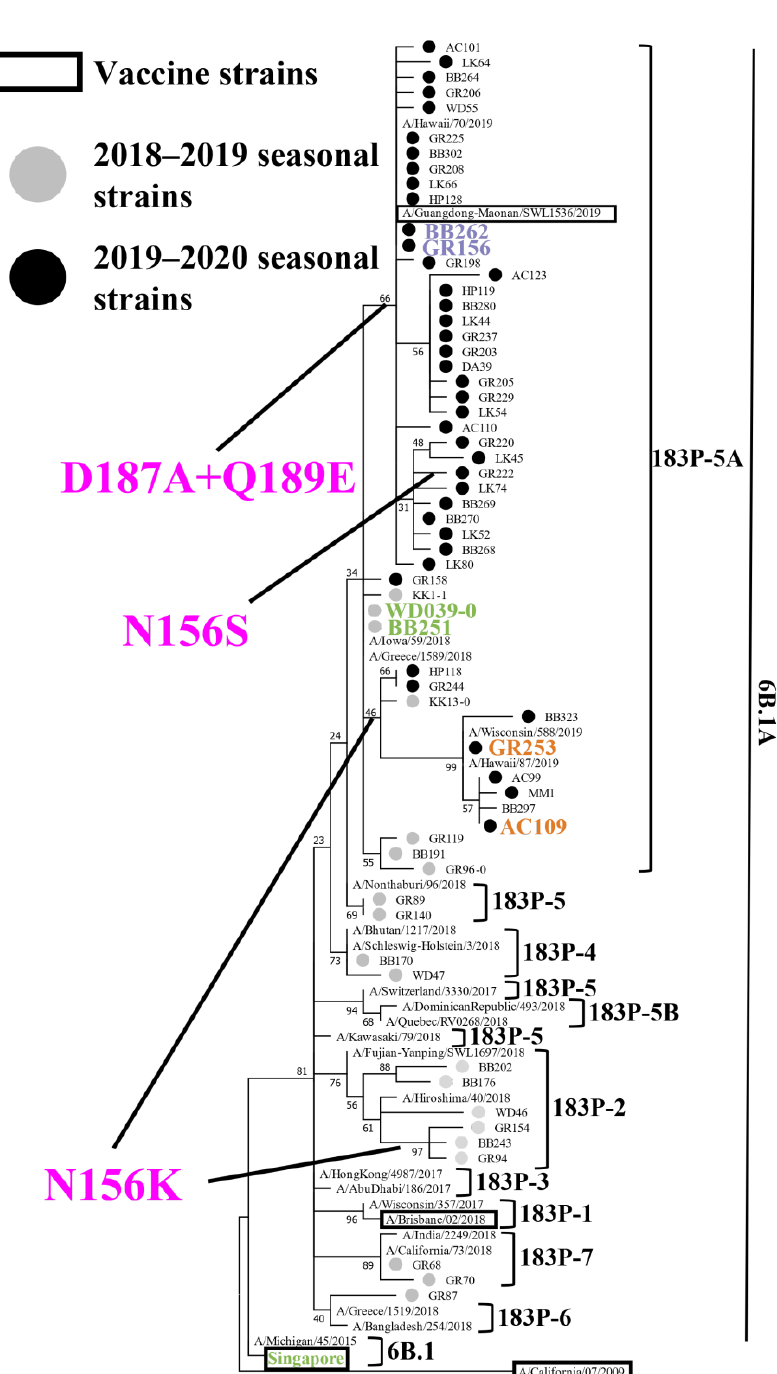
Figure 1. Phylogenetic analysis of HA. Phylogenetic tree based on the HA amino acid sequences of A(H1N1)pdm09 viruses, generated by using the Maximum Likelihood method and the Jones–Taylor–Thornton (JTT) model. Several HA sequences of representative isolates that we sequenced were used. Gray and black circles indicate isolates that were isolated in this study during the 2018–2019 and 2019–2020 influenza seasons, respectively. Current and previous vaccine strains are indicated by black squares. The branch bootstrap score is listed next to the corresponding subtree node. Amino acid substitutions delineating major branches are shown. A/Tokyo/UT-WD039-0/2019 (WD039-0) and A/Tokyo/UT-BB251/2019 (BB251) indicated in green; A/Tokyo/UT-BB262/2019 (BB262) and A/Tokyo/UT-GR156/2019 (GR156) indicated in purple; A/Tokyo/UT-GR253/2020 (GR253), and A/Tokyo/UT-AC109/2020 (AC109) indicated in orange; and A/Singapore/GP1908/2015 (Singapore) shown in green were used for the antigenic analysis. A/California/04/2009 is defined as an